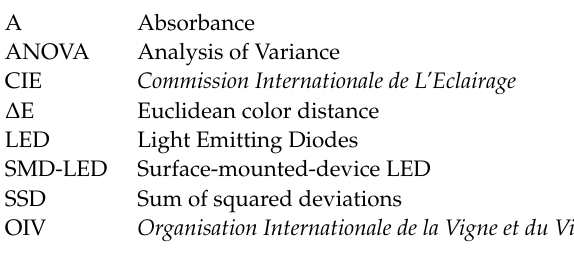
red wines, Table S2: Variety, Origin, and Vintage of the used white wines, Table S3: Photometer comparison regarding sipper and photometer configuration, Figure S1: Python code for correlation matrices, Figure S2: MATLAB code for interpolation with cubic splines, and Figure S3: MATLAB code for interpolation according to